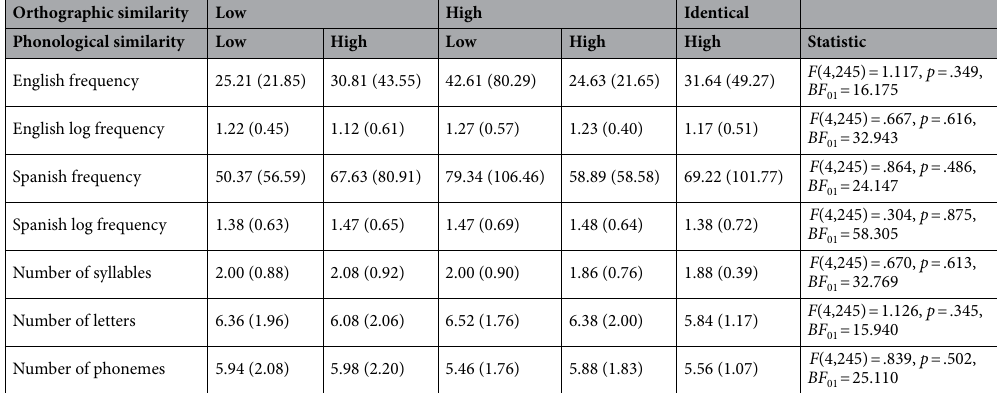
Table 1. Means, standard deviations, and statistics for variables stimuli were matched on. Values are means with standard deviations in parentheses. The N in all cases is